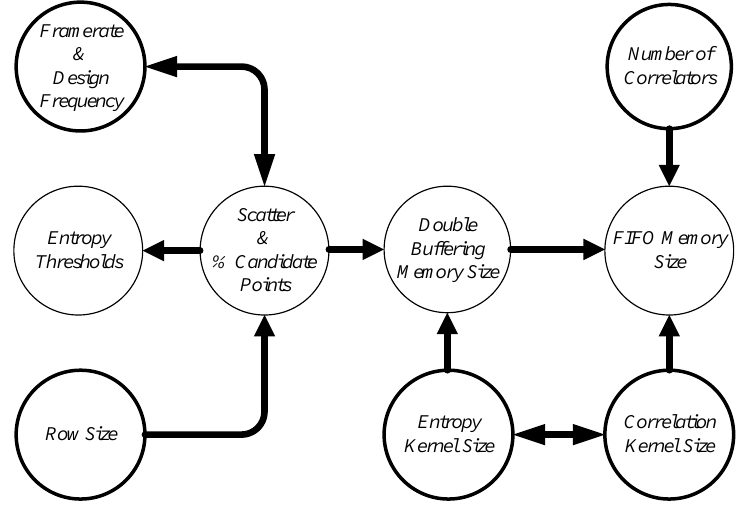
Figure 12. Relationship between parameters: Influence and